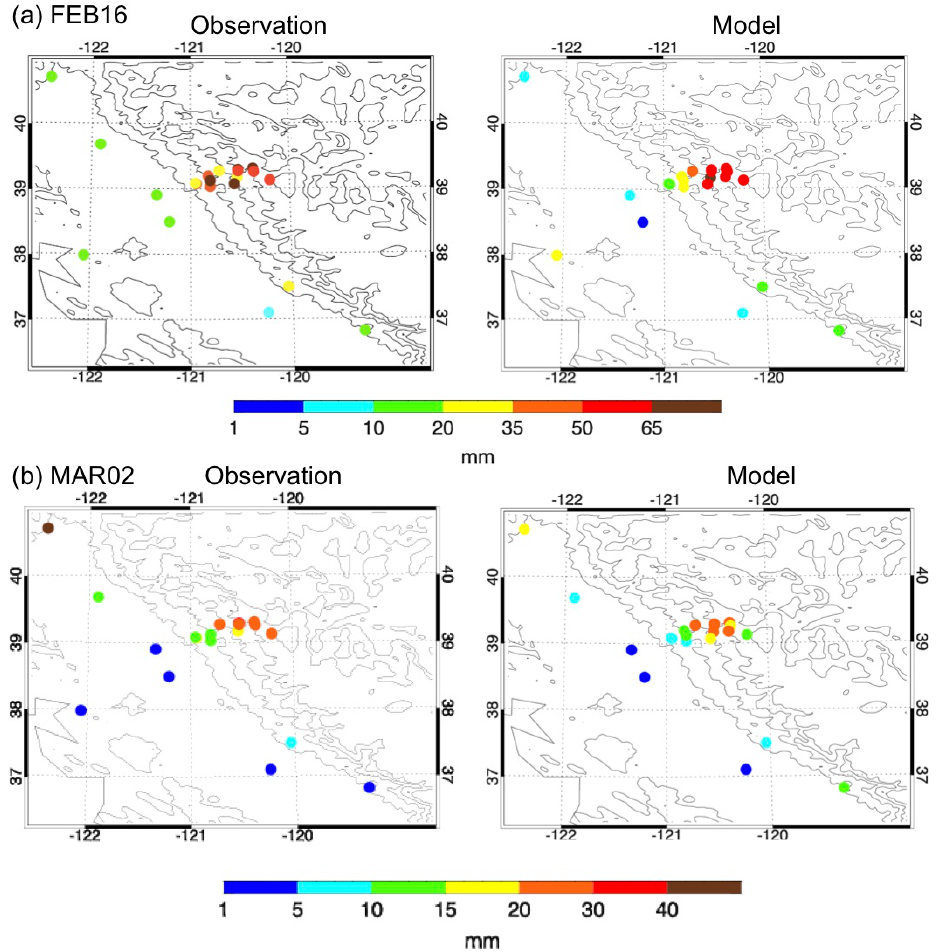
Fig. 4. Comparison of model accumulated precipitation from the base run (LoCCN&Dust) with observations for (a) FEB16 and (b) MAR02 during the day (00:00–23:00UTC). The day refers to 16 February for the FEB16 case, and 2 March for the MAR02